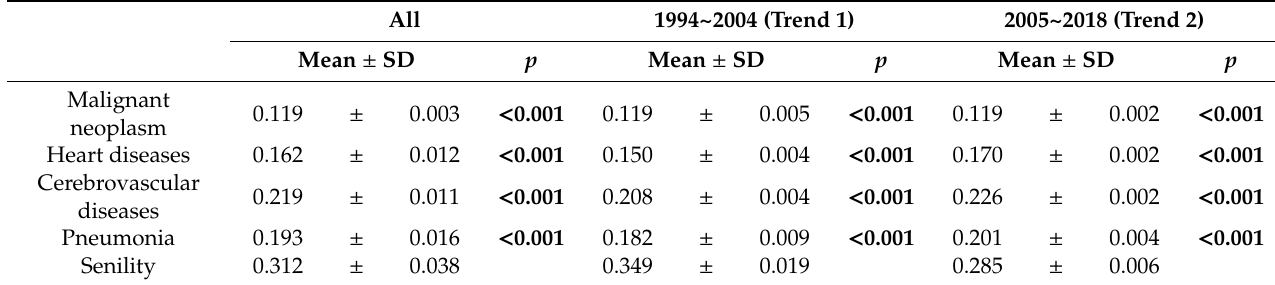
Table 2. Comparison of the coe ffi cient of variation among deaths stratified by cause in all 47 prefectures in Japan. All